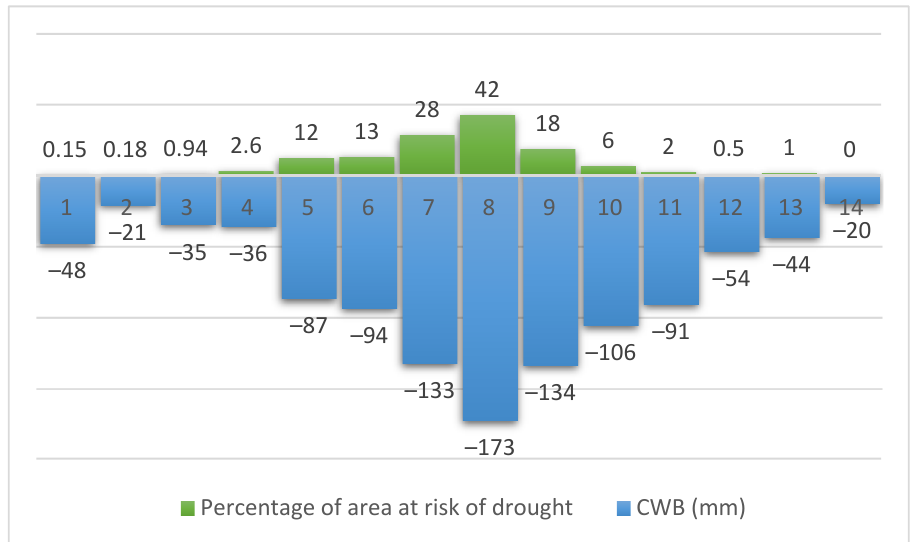
Figure 7. Temporal dynamics of drought in 14 IUNG reporting periods based on climatic water balance (CWB) values and percentage of area at risk of drought average values for Poland without regional differentiation.